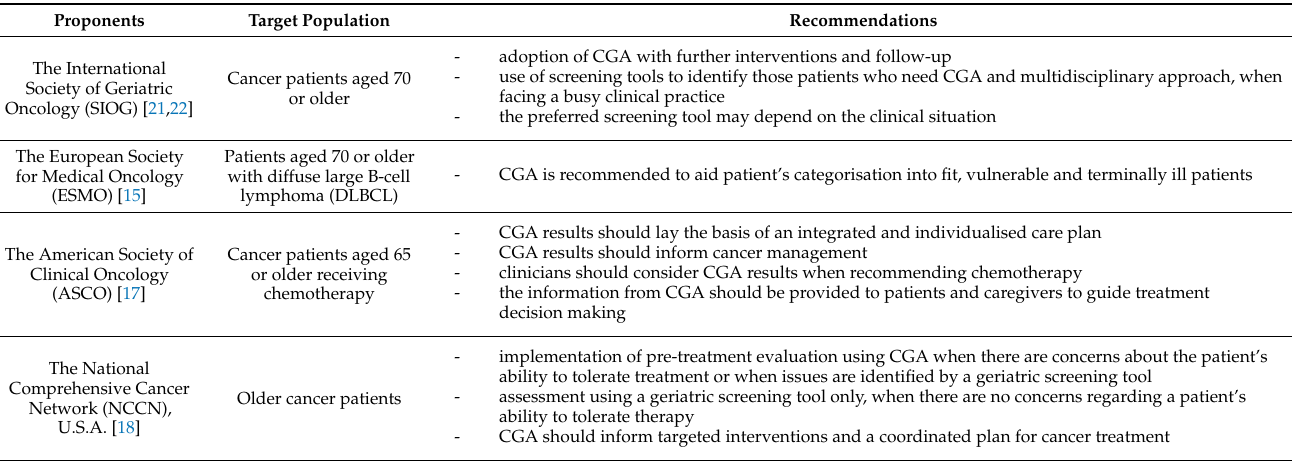
Table 1. Recommendations in the CGA by scientific